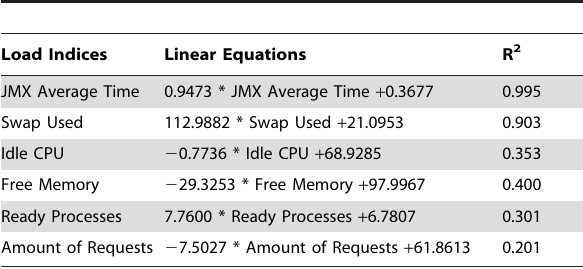
Table 5. Linear equations used to estimate the service runtimes and their coefficients of